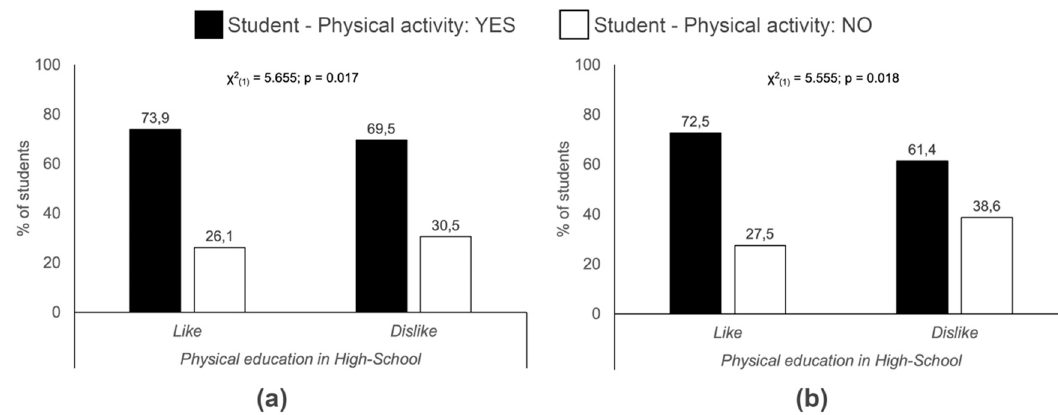
Figure 3. Relation between current physical activity and enjoyment of physical education in secondary school. ( a ) Total sample; ( b ) Women.